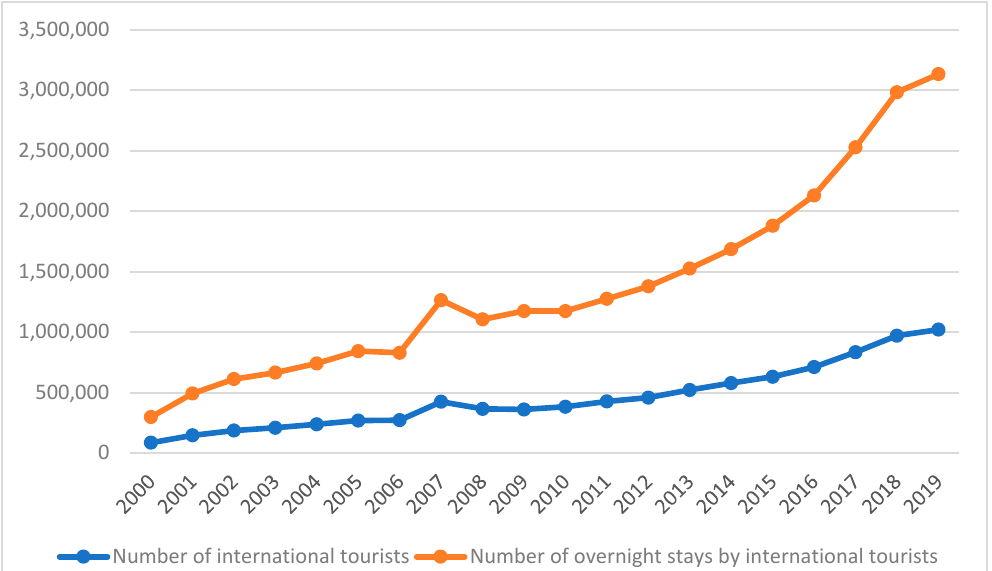
Figure 2. International tourist traffic in Belgrade 2000–2019 (Source: Data from Statistical Office of the Republic of Serbia 2020).